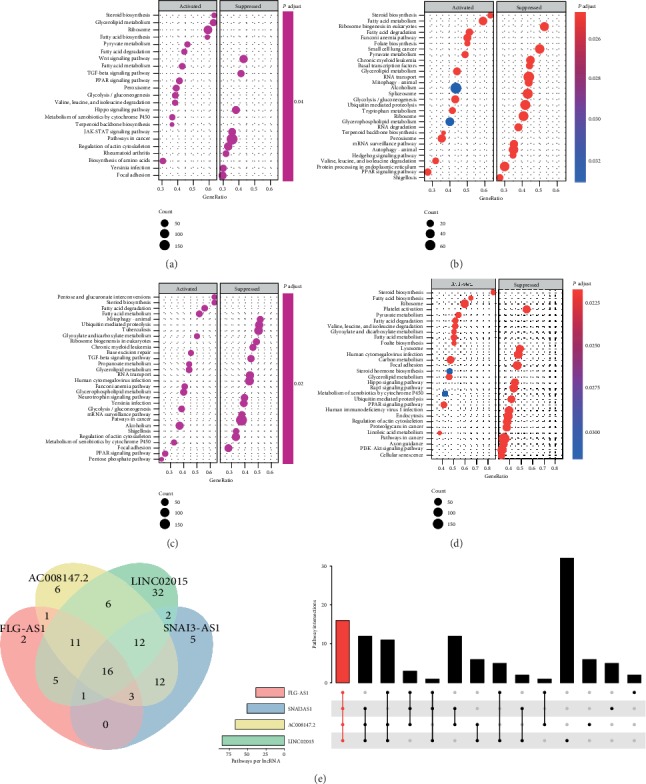
Gene Set Enrichment Analysis for lncRNAs in the ceRNA network. The top 30 pathways of FLG-AS1 (a), SNAI3-AS1 (b), AC008147.0 (c), and LINC02015 (d) enrichment analysis are shown by bubble charts. The Venn and UpSet plots show the pathways for the coenrichment of four lncRNAs (e).